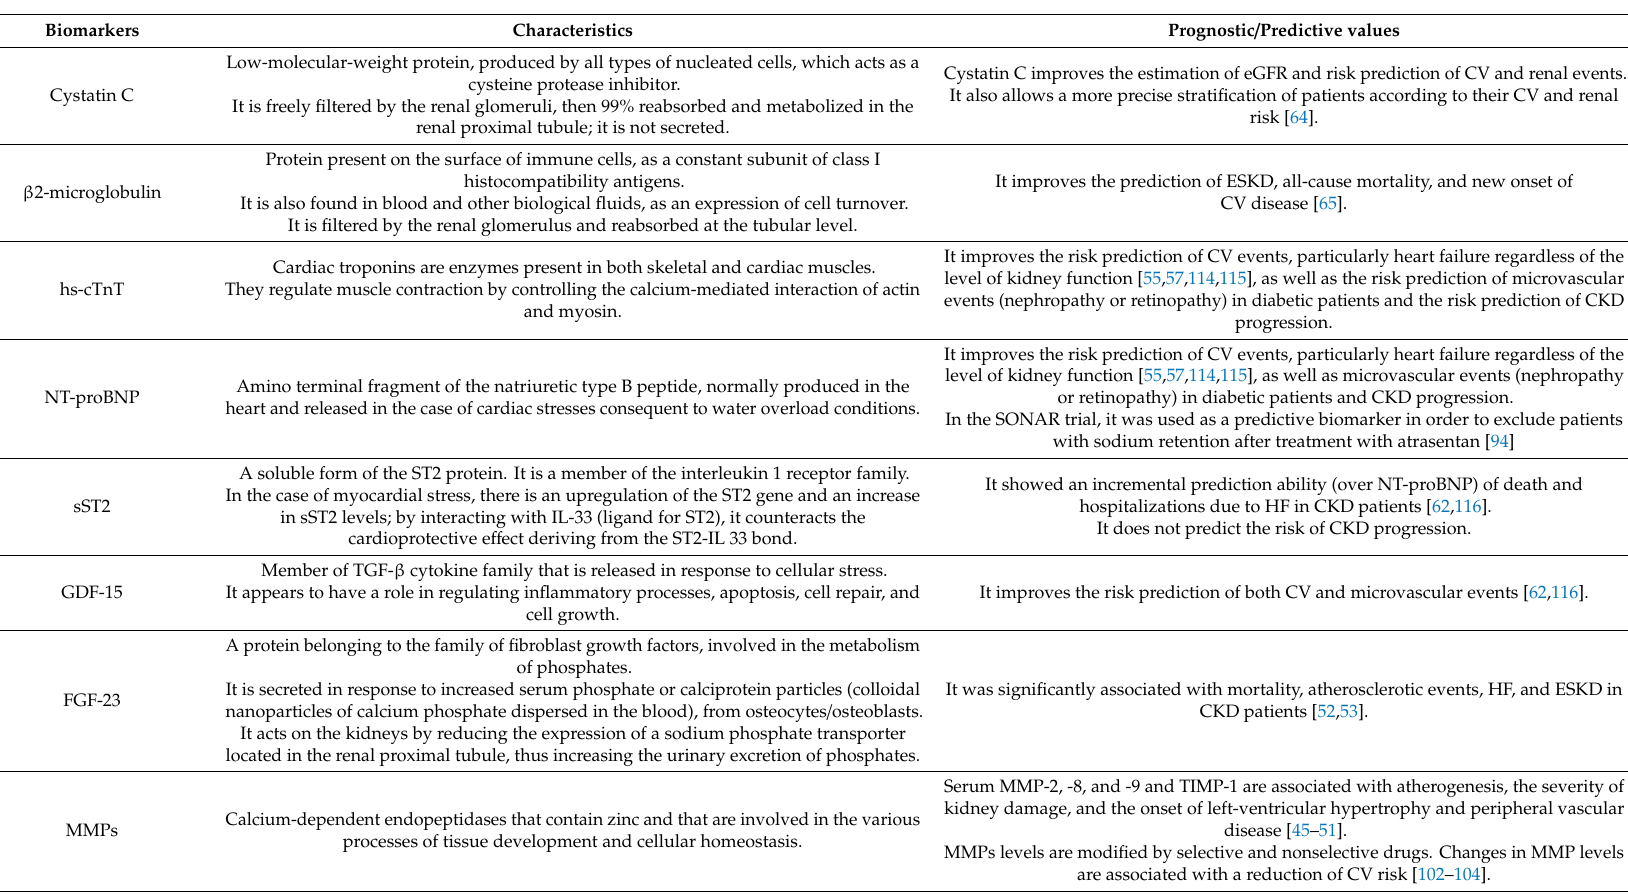
Table 1. Summary of the principal prognostic and predictive biomarkers in chronic kidney disease